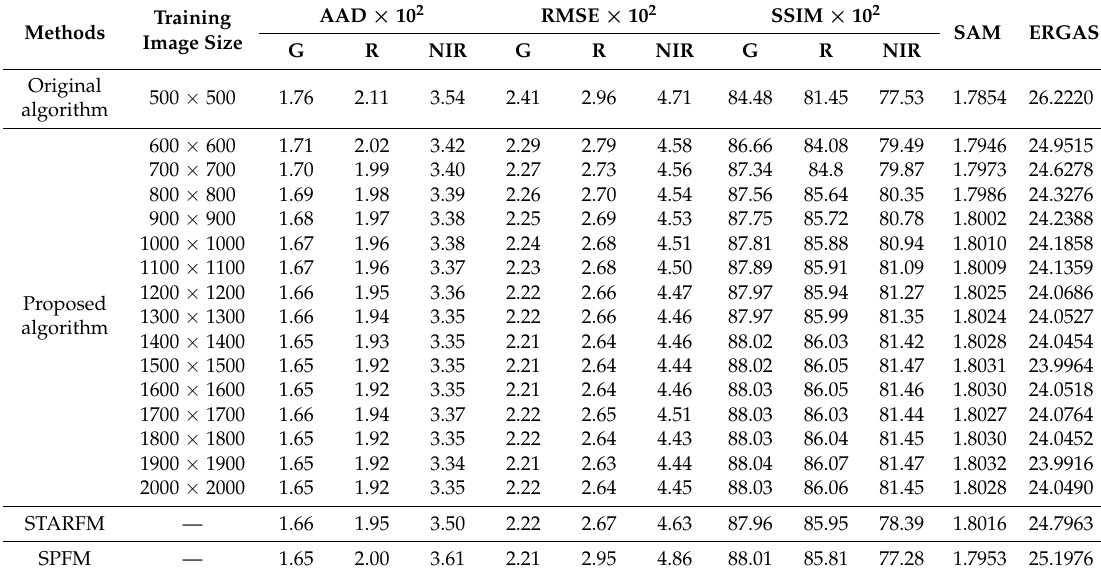
Table 5. Assessment indices of the spatially extended fusion with the urban dataset for modeling reflectance on 10 July 2017.